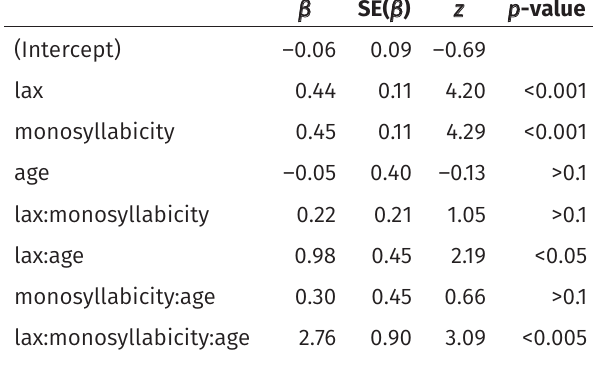
Table 12: Regression model for the child